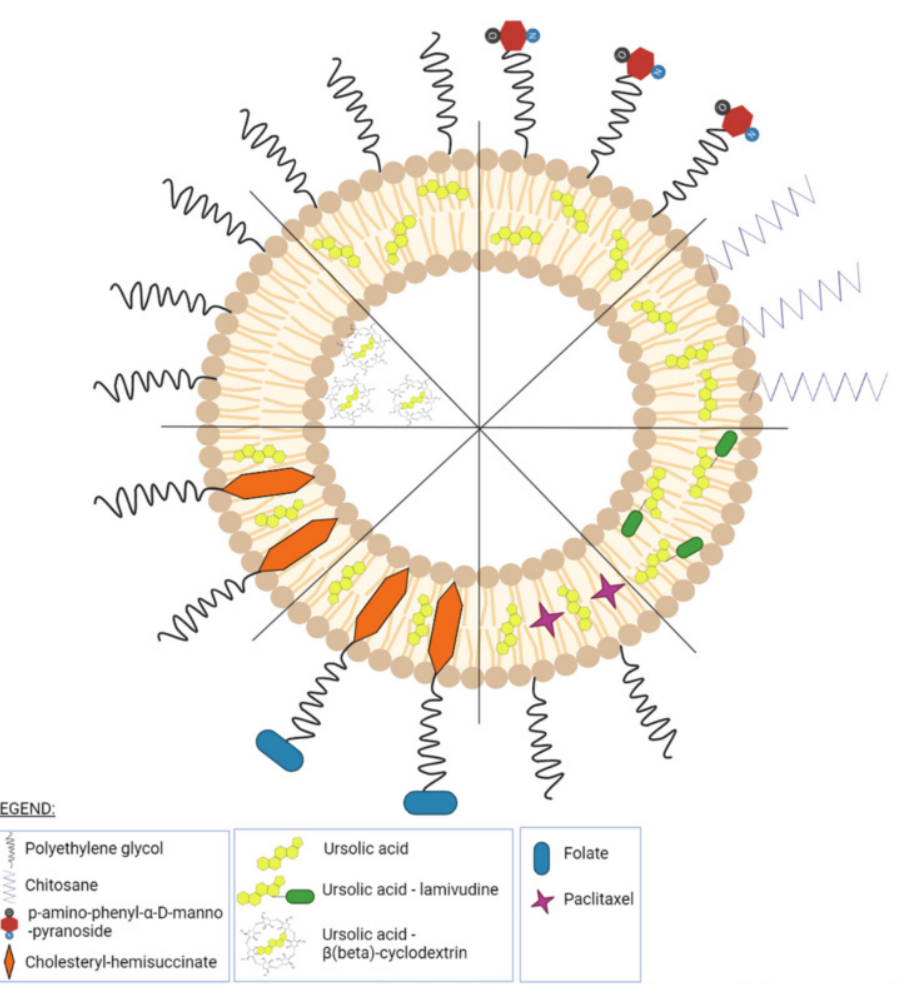
Figure 23. Schematic representation of different reported UA liposomal formulations. Created with BioRender.com (accessed on 10 January